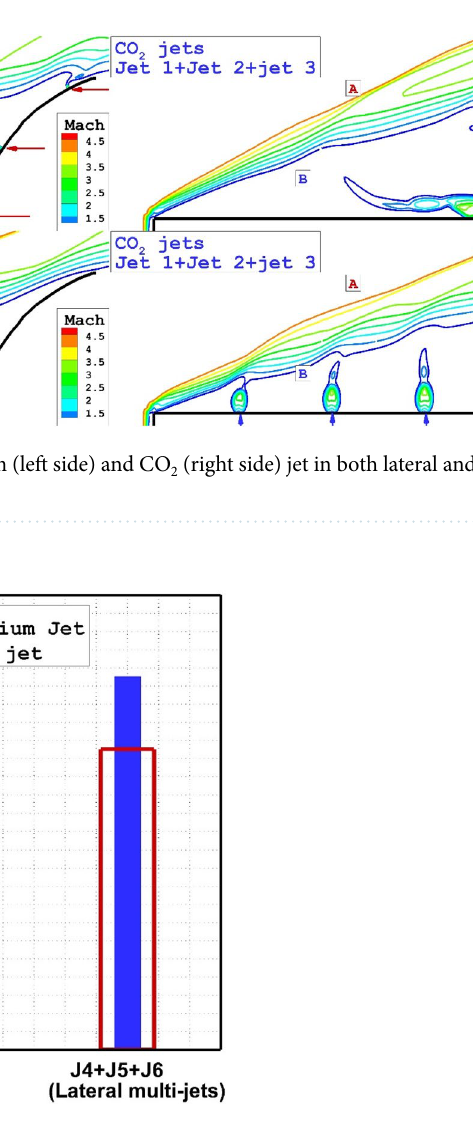
Figure 8. 3-D comparison of three helium (left side) and CO 2 (right side) jet.